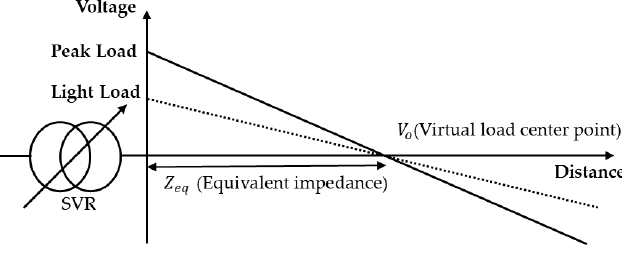
Figure 1. The concept of LDC control method.